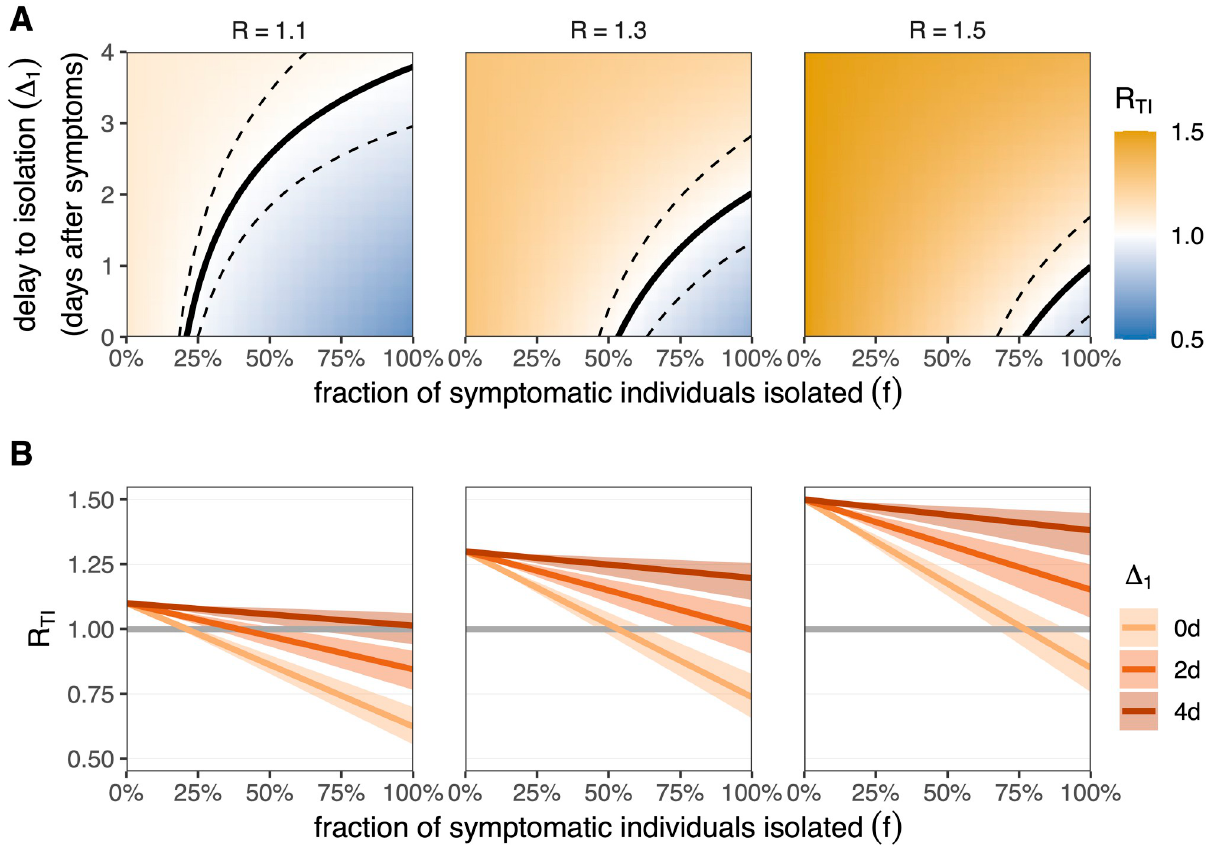
Fig 2. The reproductive number R TI under testing & isolation only. A: The impact of testing & isolation on R TI as a function of the fraction of symptomatic individuals that are isolated ( f ; x-axis) and delay to isolation after symptom onset ( Δ 1 ; y-axis) for different baseline R values (columns). The black line represents the critical reproductive number R TI = 1. Above this line (orange zone) we have on average more than one secondary infection per infected and the epidemic is growing. Below this line (blue zone) we have less than one secondary infection per infected and the epidemic is suppressed. Dashed lines are the 95% confidence interval for this threshold, representing the uncertainty in the inferred generation time distribution and infectivity profile. B: Lines correspond to slices of panel A at a fixed delay to isolation Δ 1 = 0, 2, or 4 days after symptom onset (colour). Shaded regions are 95% confidence intervals for the reproductive number, representing the uncertainty in the inferred generation time distribution and infectivity profile. Horizontal grey line is the threshold for epidemic control ( R TI = 1). We fix the fraction of transmission that is attributed to asymptomatic infections to α = 20%, where asymptomatic individuals are not tested or isolated. Data provided in S1 Dataset.